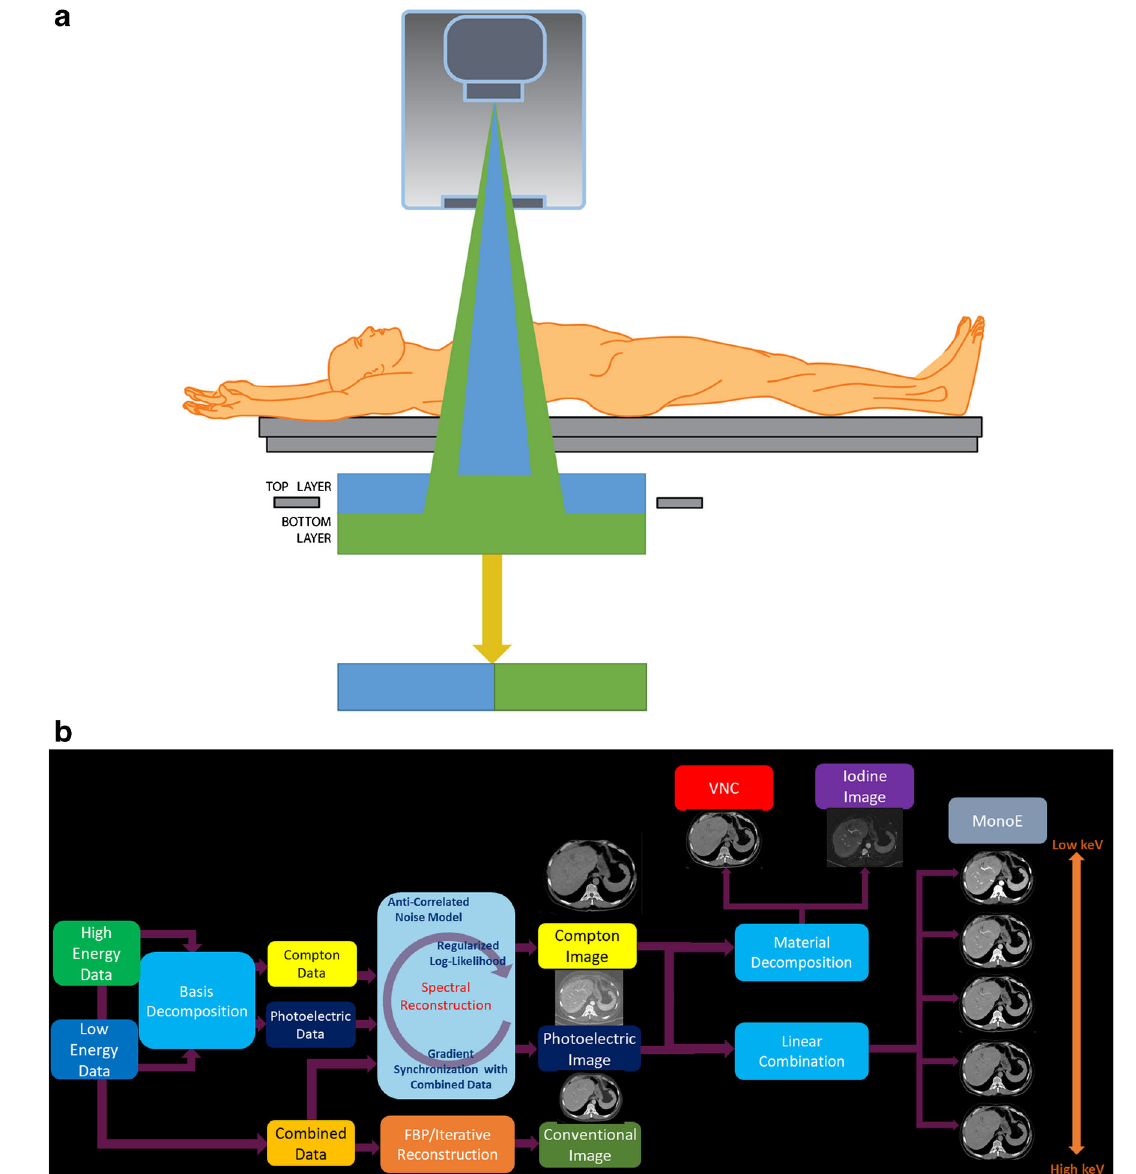
foranalogue to digitalconversion (notshown here). ( b ) Diagramshowing the technique of image generation from the SDCTscanner. Data from the two layers is utilised to generate photoelectric and Compton scatter basis pairs. Linear combination gives virtual monoenergetic images, while material decomposition gives iodine-density, virtual non-contrast and effective atomic number-based